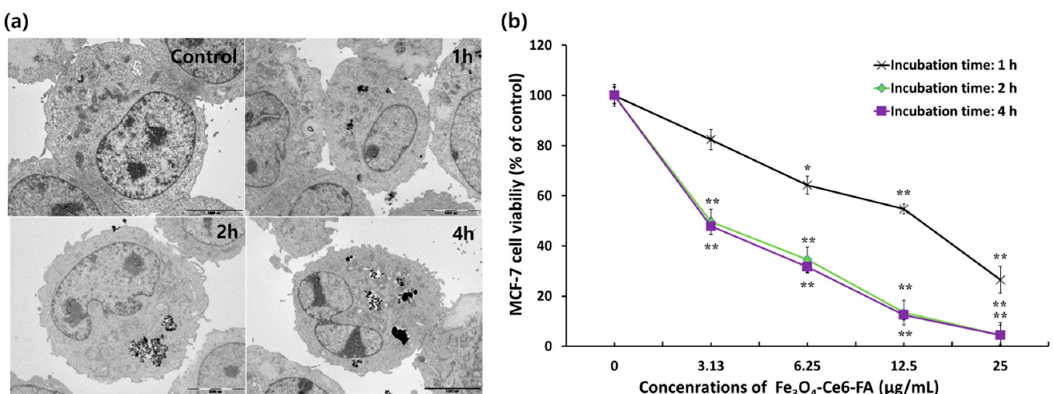
Figure 2. Cellular uptake images and anticancer activities of FCF NPs following photodynamic therapy (PDT) in MCF-7 cells. ( a ) Transmission electron microscope (TEM) images of FCF NPs in MCF-7 cells. TEM images of MCF-7 cells were taken after 1, 2, and 4 h of incubation with 20 µg/mL of FCF NPs. Scale bar = 5 µm. ( b ) Anticancer activities of FCF NPs as a function of incubation time of these nanoparticles (NPs) in MCF-7 cells.